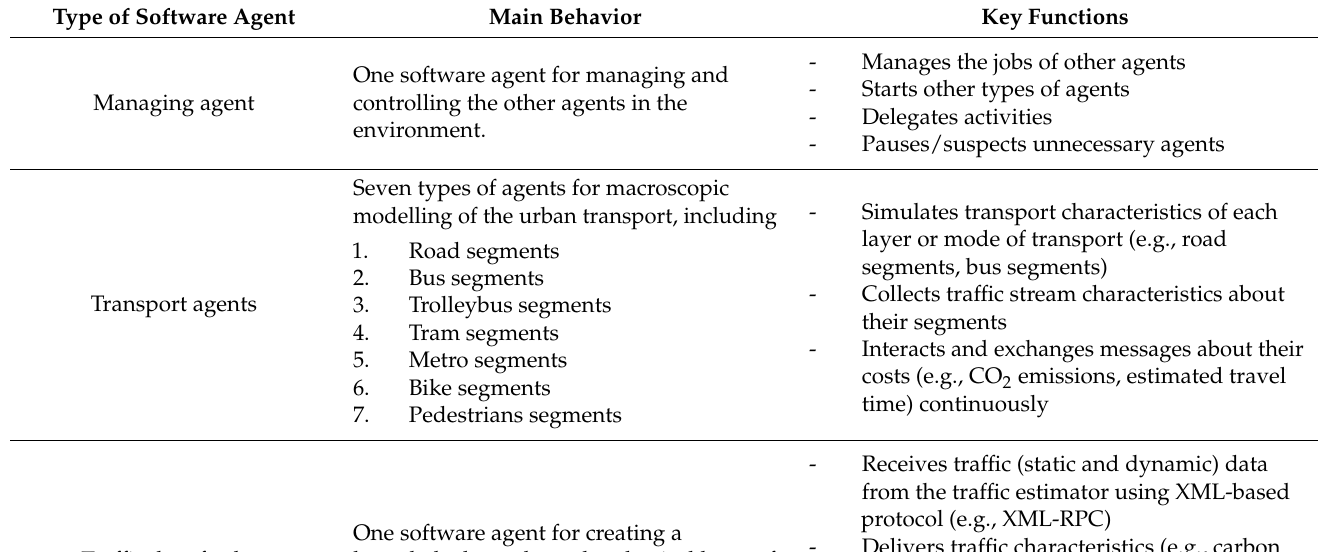
Table 2. Agent types used in our eco-friendly multimodal route recommender system.